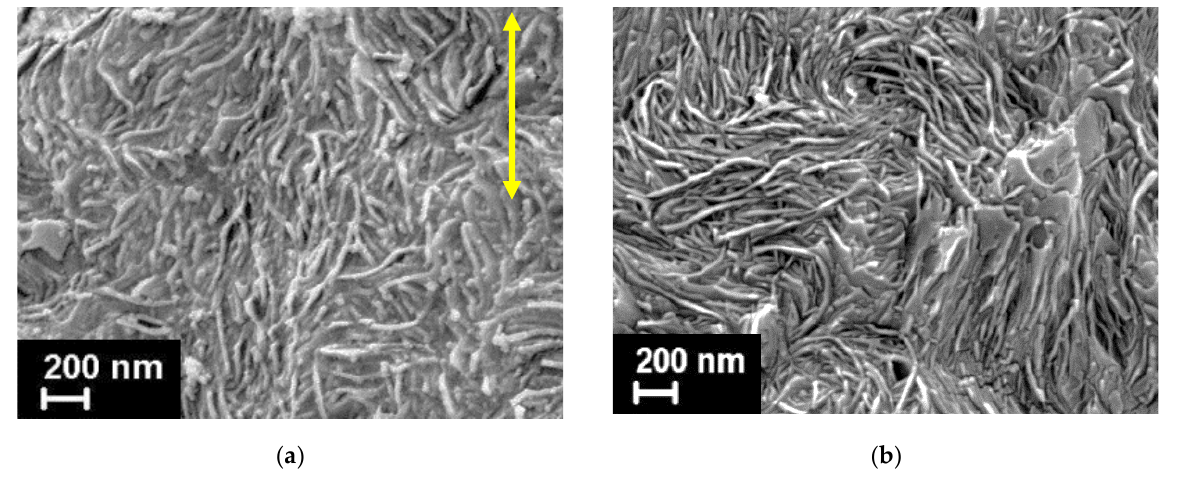
Figure 4. SEM micrographs of the pure HDPE fiber (after etching): ( a ) fiber surface; ( b ) fiber cross- section. An arrow indicates the fiber extrusion direction.